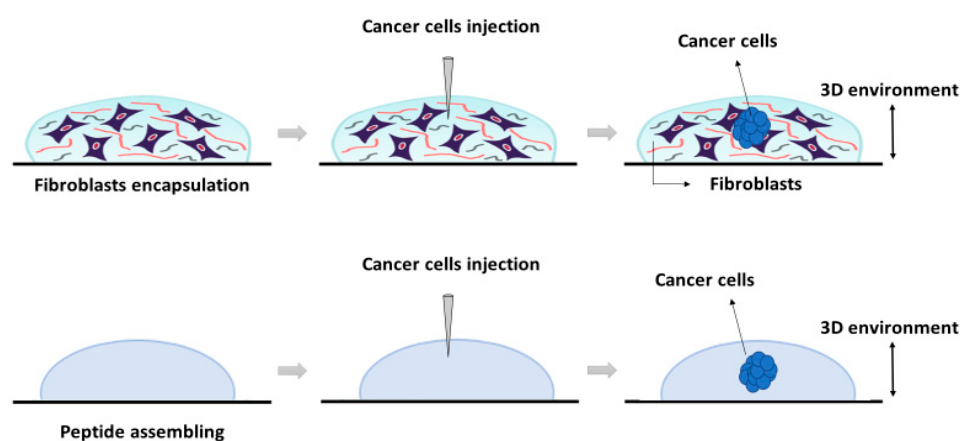
Figure 5. Schematic representation of the 3D system’s construction using the self-assembling peptide scaffold RAD16-I. The system was developed (from left to right) as follows: First, peptide was assembled in presence ( top ) or absence of fibroblasts ( bottom ). Then, cancer cells were injected into each preformed matrix ( center ). The resulting 3D cultures were cancer cells embedded into a fibroblasts matrix ( top ) or a cancer cell into an empty peptide gel ( bottom ).